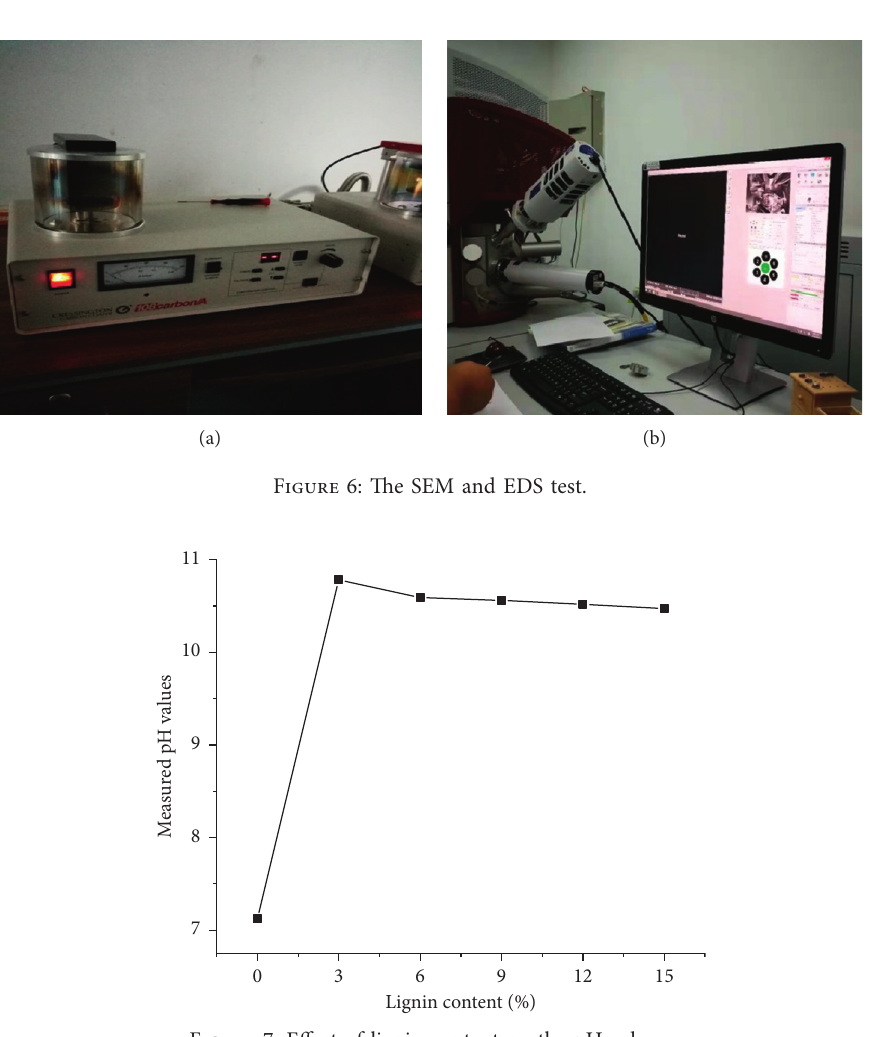
Figure 7: Effect of lignin content on the pH